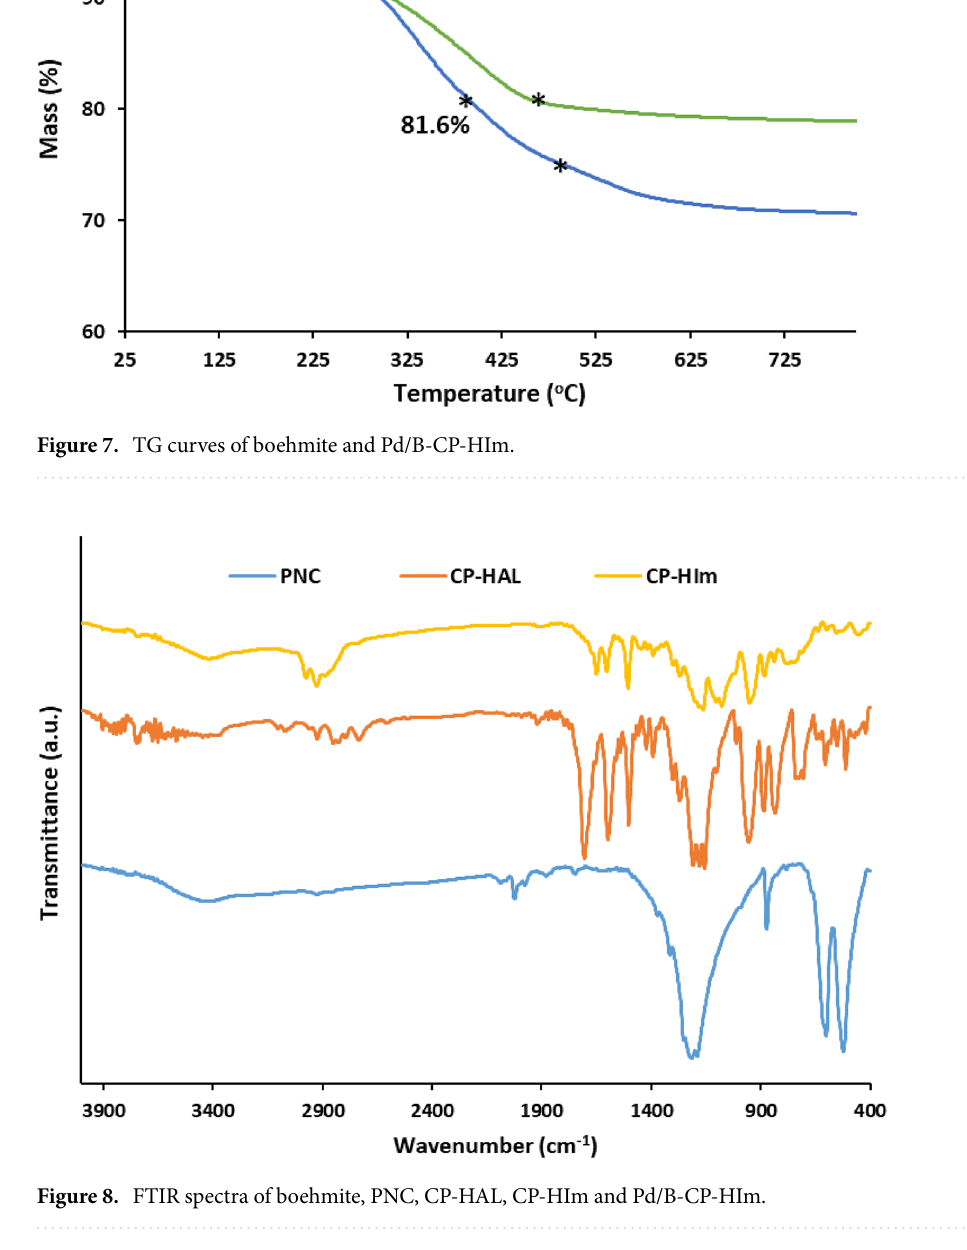
Fig. 7. In boehmite thermogram, loss of structural water at low temperature (~ 150 °C) and decomposition at elevated temperature (~ 450 °C) were detected. In the Pd/B-CP-HIm thermogram, however, three weight loss steps were observed, two of them were related to the loss of water and boehmite decomposition and one of them (detected at 380 °C, 14 wt.%) was due to the decomposition of CP-HIm. In fact, this additional weight loss step approves conjugation of the organic ligand on boehmite. Formation of Pd/B-CP-HIm was also verified via FTIR spectroscopy, Fig. 8. To have a better understanding, FTIR spectrum of Pd/B-CP-HIm was compared with that of boehmite, PNC, CP-HAL, CP-HIm and Pd/B-CP- HIm. As seen, FTIR spectrum of boehmite is in good accordance with the literature and showed the absorbance